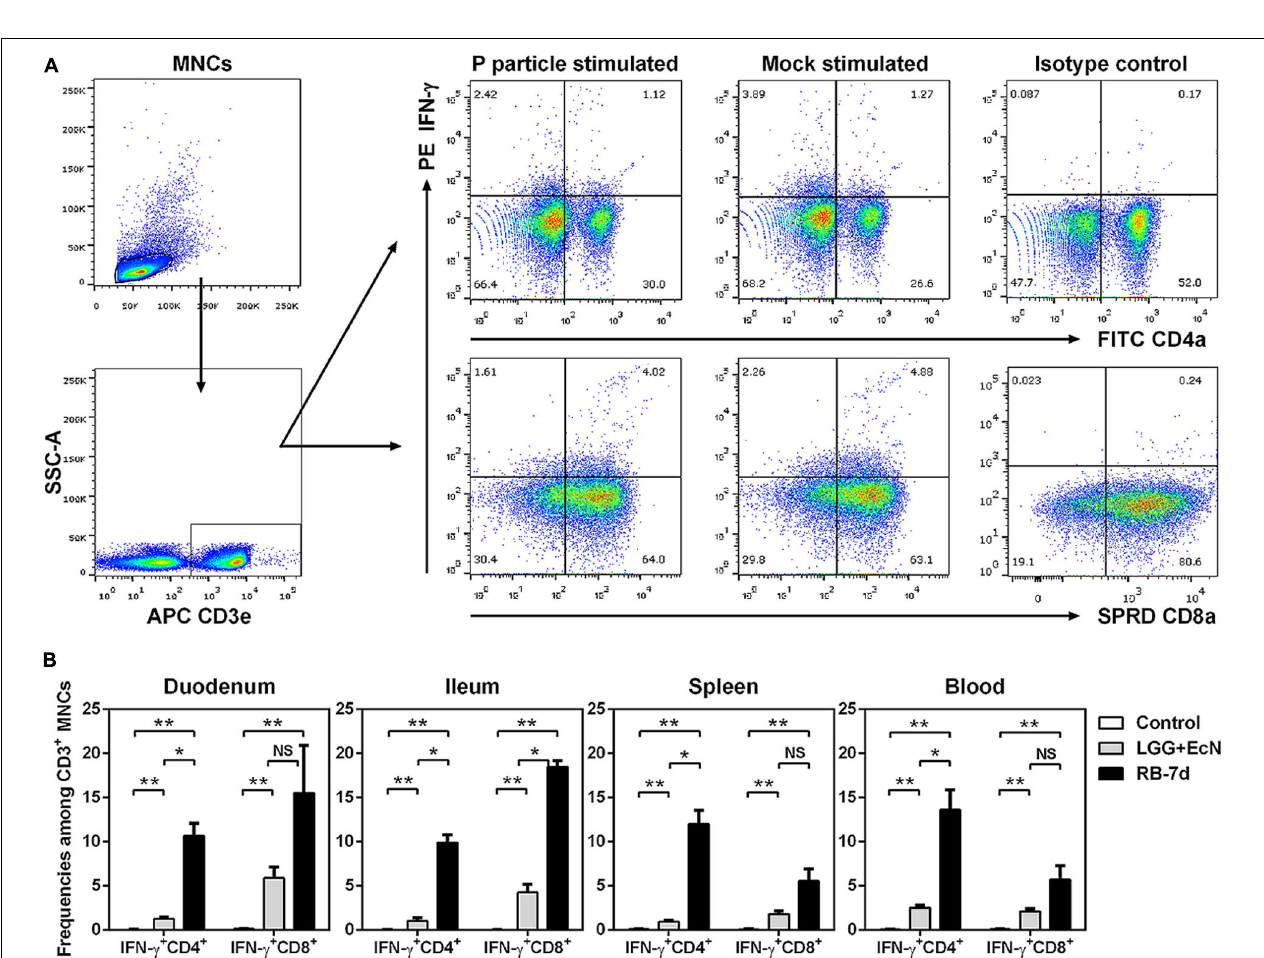
FIGURE 4 | LGG + EcN and RB stimulated IFN- γ + T cell responses. (A) Gating strategies for IFN- γ + CD3 + CD4 + (Th) cells and CD3 + CD8 + (CTL) cells. Representative dot plots showing frequencies of HuNoV-specific (P particle stimulated) and non-specific (mock stimulated) IFN- γ + T cells in ileum isolated from LGG + EcN colonized Gn pigs. SSC-A, side scatter area; APC, allophycocyanin; FITC, fluorescein isothiocyanate; SPRD, spectral red; PE, phycoerythrin. (B) Non-specific IFN- γ + T cells in intestinal (duodenum, ileum) and systemic (spleen, blood) tissues on PID7. Sample sizes are shown in Table 1 . Data are presented as means ± SEM. Statistics were determined by Kruskal–Wallis test. NS, not significant, ∗ P < 0.05, ∗∗ P < 0.01.